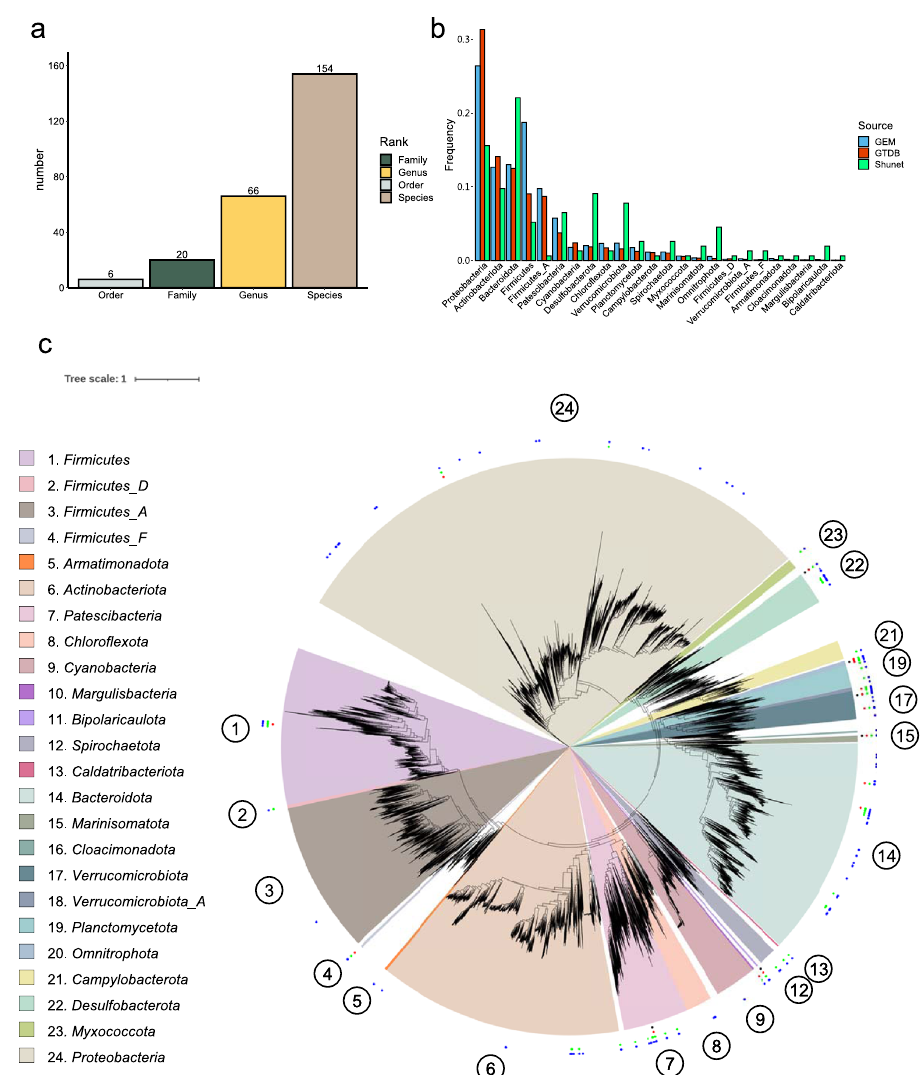
Fig. 2 Taxonomical and molecular phylogenetic analyses of recovered bacterial MAGs. a The numbers of novel taxonomic ranks of MAGs assigned by GTDB-Tk. b The phylum frequencies in the MAG collection from the Shunet dataset, GTDB representative genomes, and GEM dataset. c A phylogenetic tree based on the concatenation of 120 single-copy gene protein sequences. After masking, 5040 amino acid sites were used in the analysis. The phylogenetic tree includes 188 recovered bacterial MAGs and 30,238 bacterial representative genomes in GTDB-r95. The blue points represent the placement of MAGs that are classi fi ed as novel species, the green points represent novel genera, the red points represent novel families, and the black points represent novel orders. The numbers in the circle are phyla in the legend. Scale bar represents changes per amino acid